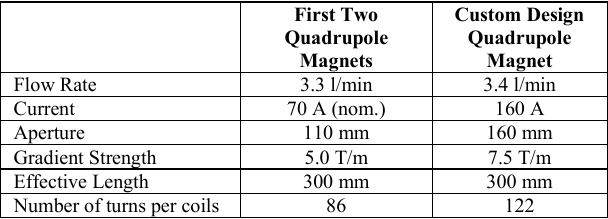
TABLE IV. Properties of Quadrupole Magnets of